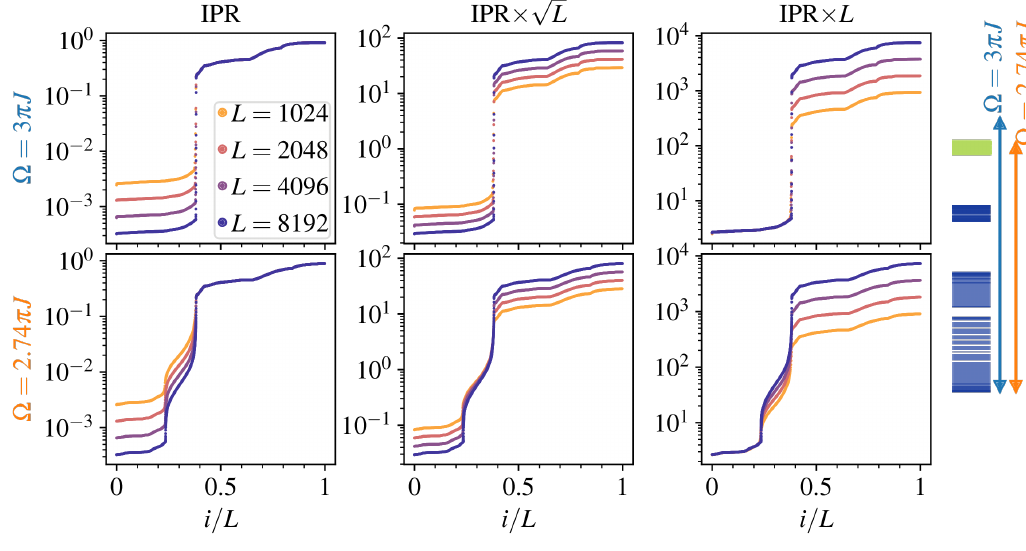
Figure 6: Dependence of multifractality on driving frequency. Absence and presence of multi- fractal states in the Floquet spectrum when the frequency of the driving is larger and smaller than the bandwidth of the undriven spectrum, respectively. The two rows correspond to the two values of Ω , also shown schematically by the arrows next to the undriven spectrum, whereas the columns correspond to different scalings of IPR with L . The presence (absence) of multifractal states can be identified from the presence (absence) of finite fraction of states with IPR ∼ L − 1 / 2 in the second